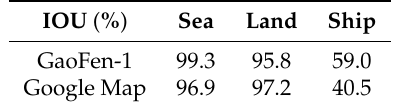
Table 7. IOUs of the proposed method without balanced